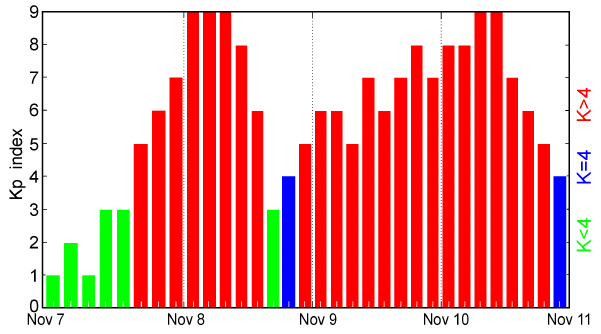
Fig. 20. The estimated planetary Kp Index from 7–11 November 2004. This index combines disturbances in the Earth’s magnetic field measured at nine separate observatories in North America on a scale from 0–9. Each bar is for a three-hour interval in UT and Kp values below 4 indicate little disturbance. The bars are green when Kp < 4; blue when Kp=4, and red when Kp > 4. Red bars indicate a storm warning. Values greater than 7 indicate a large